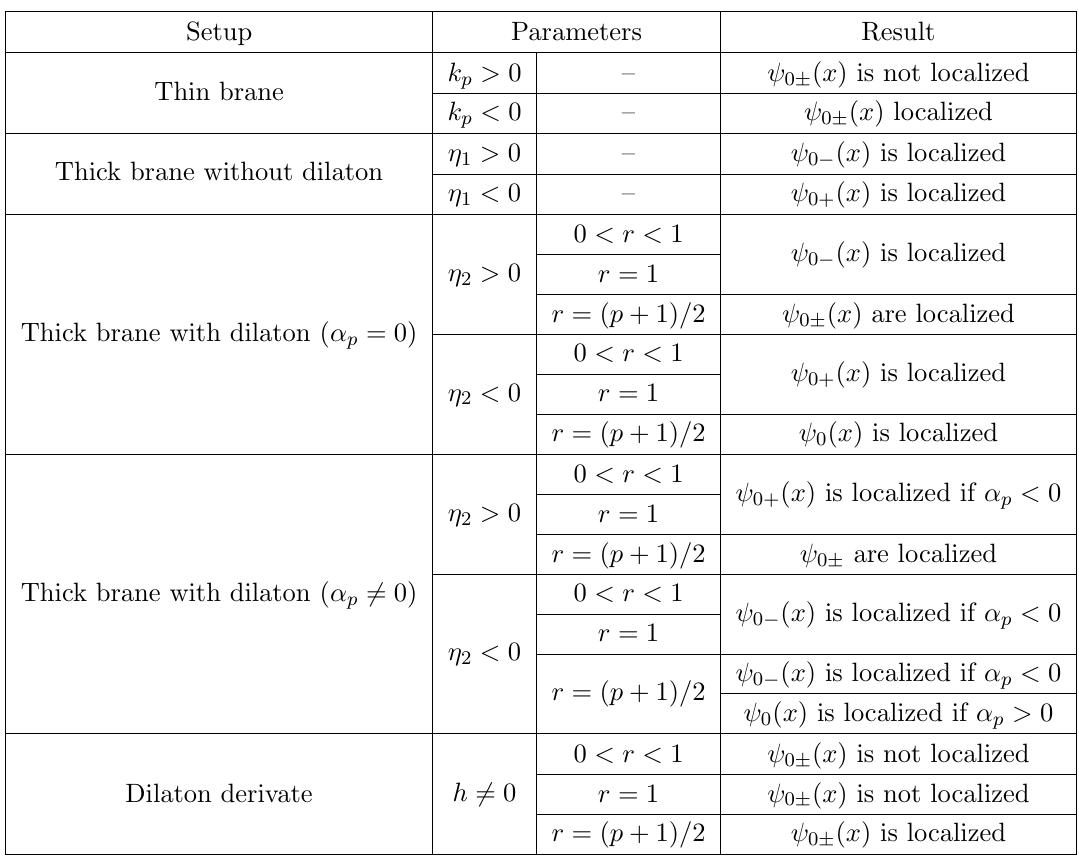
dilaton coupling case, H ( (cid:30); (cid:25) ) = h(cid:25) , the parameter h does not in(cid:13)uence in the